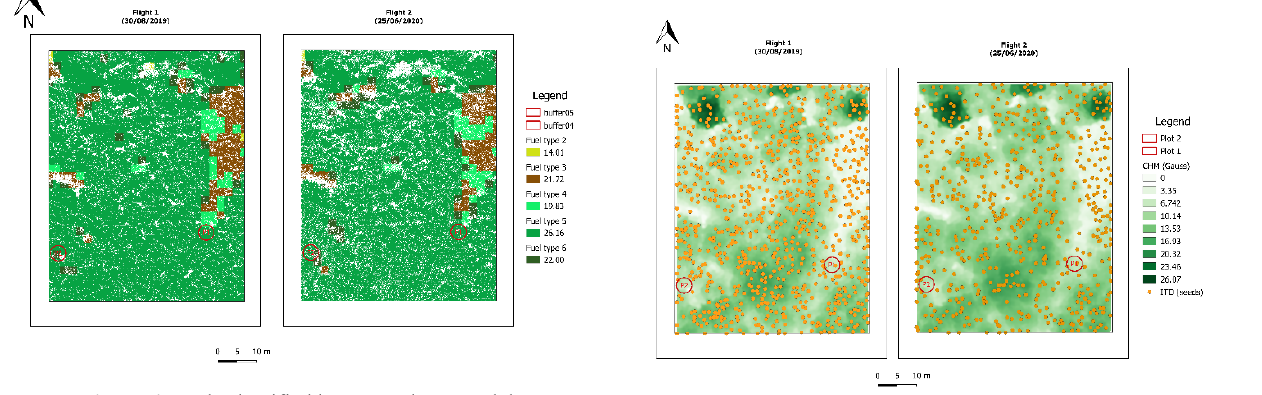
Figure 4. Fuels classified by Prometheus model.